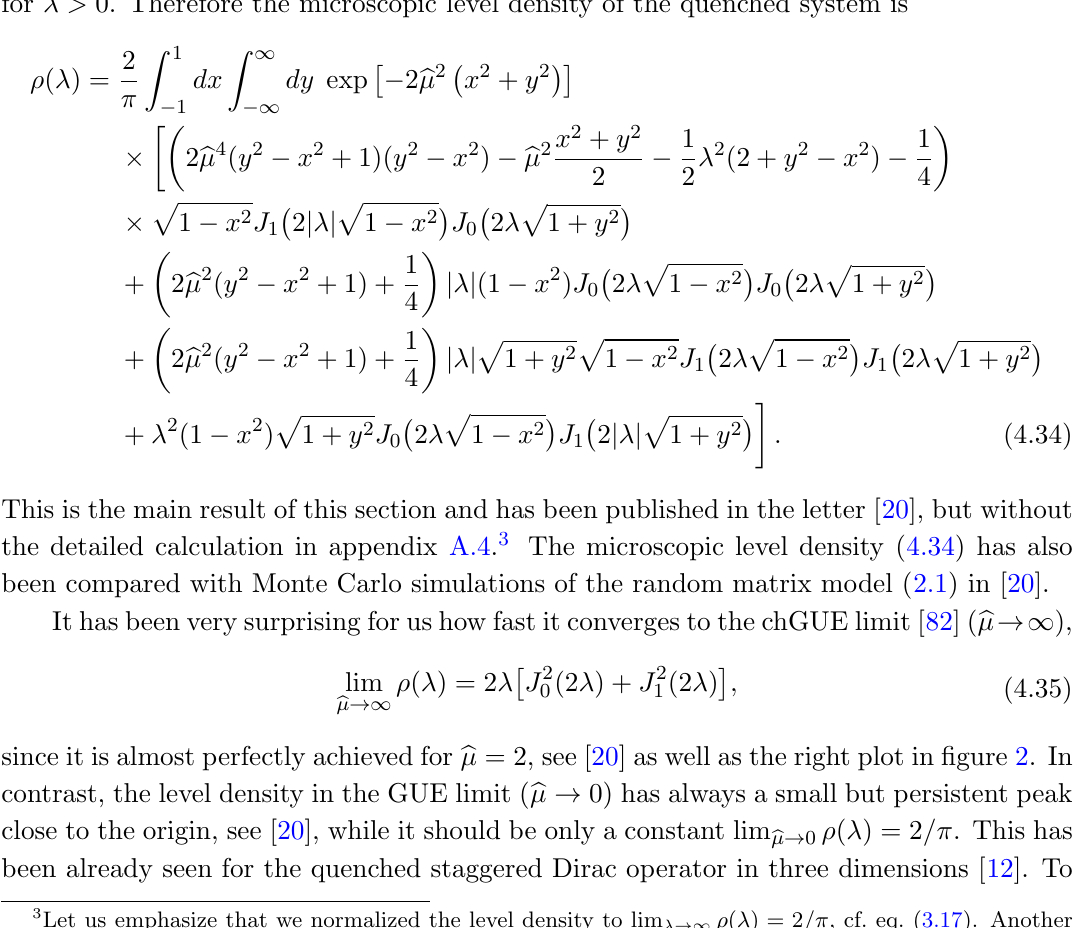
Figure 2 . The analytical result (4.34) for the microscopic level density of the random matrix model (2.1) for several coupling constants sult (4.36) is approached while in the right plot the \large" that in the left plot we have rescaled the singular values by narrow strip about the origin and the remaining density can be well approximated by a constant (cid:26) ( (cid:21) ) (cid:25) 2 =(cid:25)